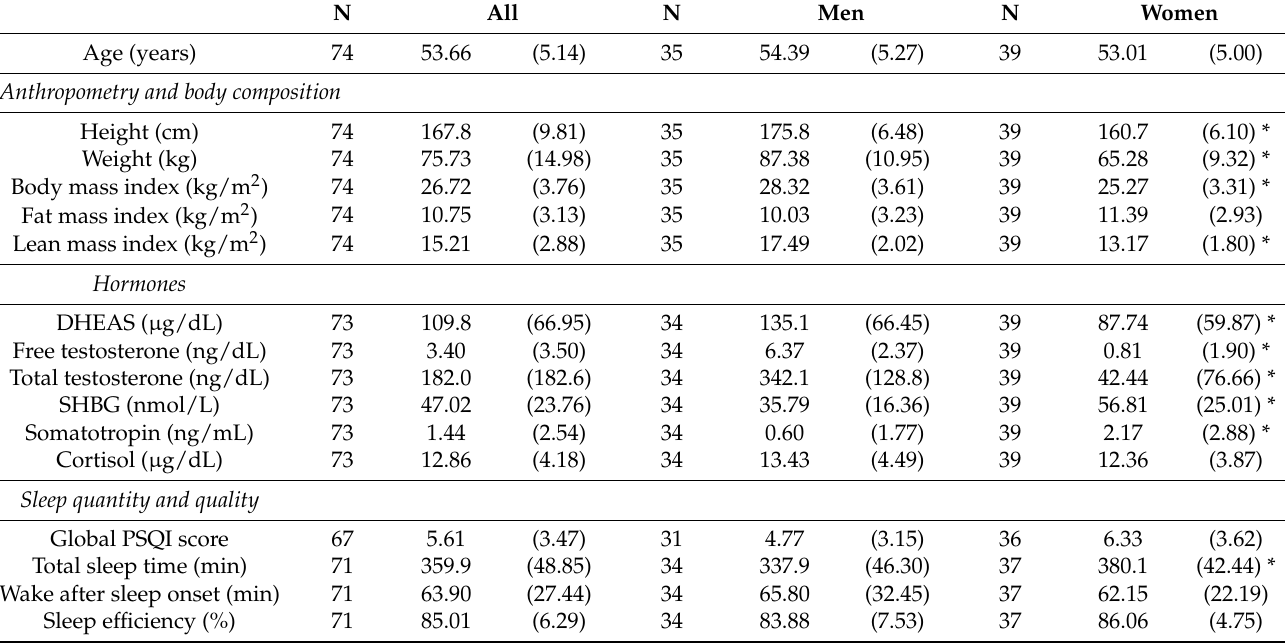
Table 1. Descriptive characteristics of